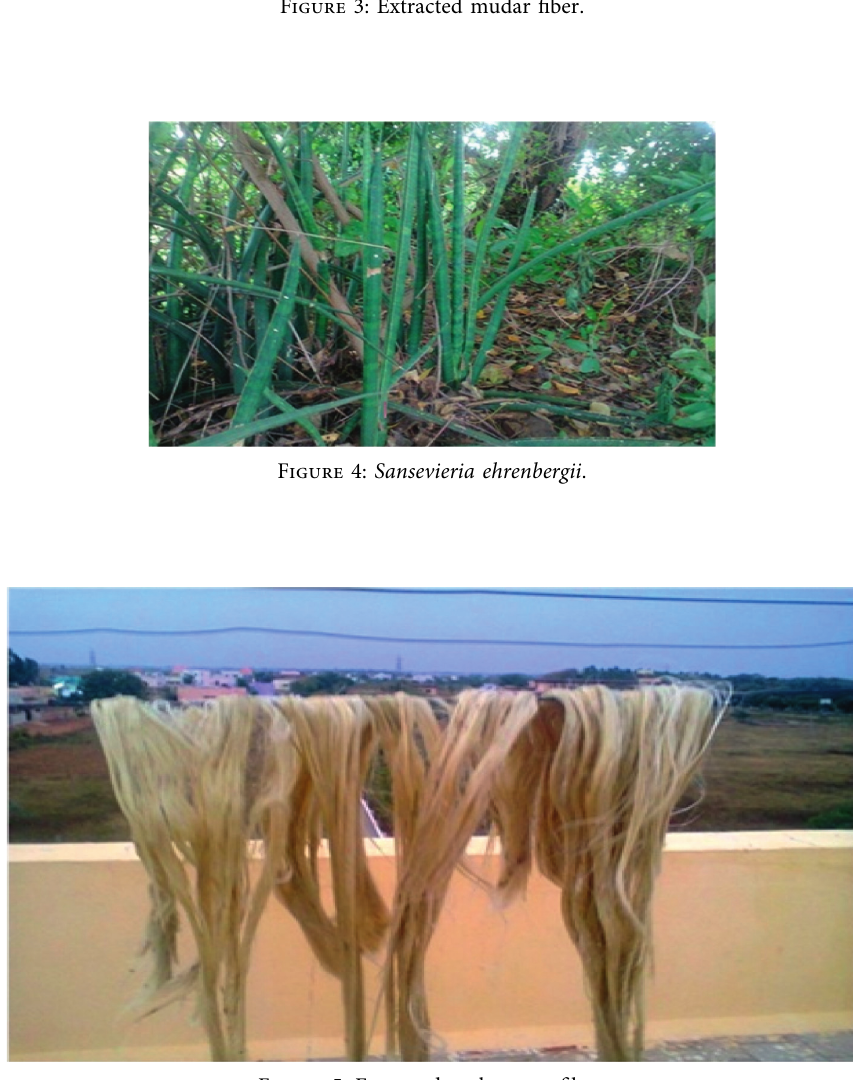
Figure 5: Extracted snake grass fiber.